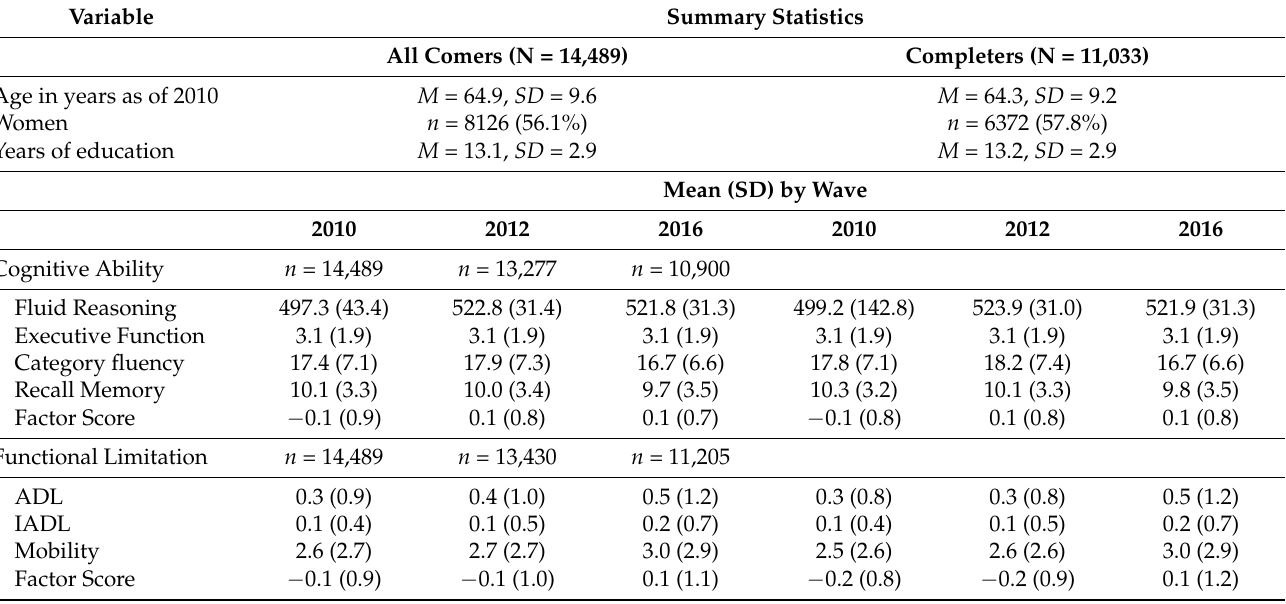
Table 1. Sample descriptive statistics (N = 14,489) including demographic, cognitive, and functional limitation